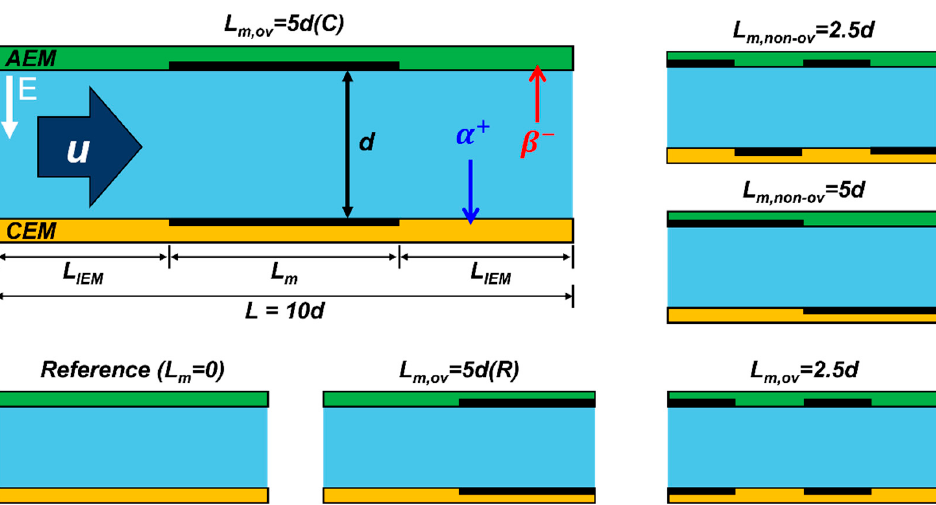
Figure 3. Schematic of the main channel with the five types of masking. All membranes were prepared using non-conductive masking film to cover the same areas, but the patterns differed in terms of unit masking length and local position. “d” is the intermembrane distance between the AEM and the CEM, and thus, represents the width of the fluidic flow channel. “L IEM ” and “L m ” are the unmasked and masked lengths, respectively. The total length, “L”(=10d = 15 mm), is the sum of the masked and unmasked lengths. L m,ov and L m,non-ov differed according to the vertical alignment of the masked regions of the AEM/CEM. Of the L m = 5d membranes, the masking film was located on the right side (L m,ov = 5d (R)) or the center of the membrane (L m,ov = 5d (C)).